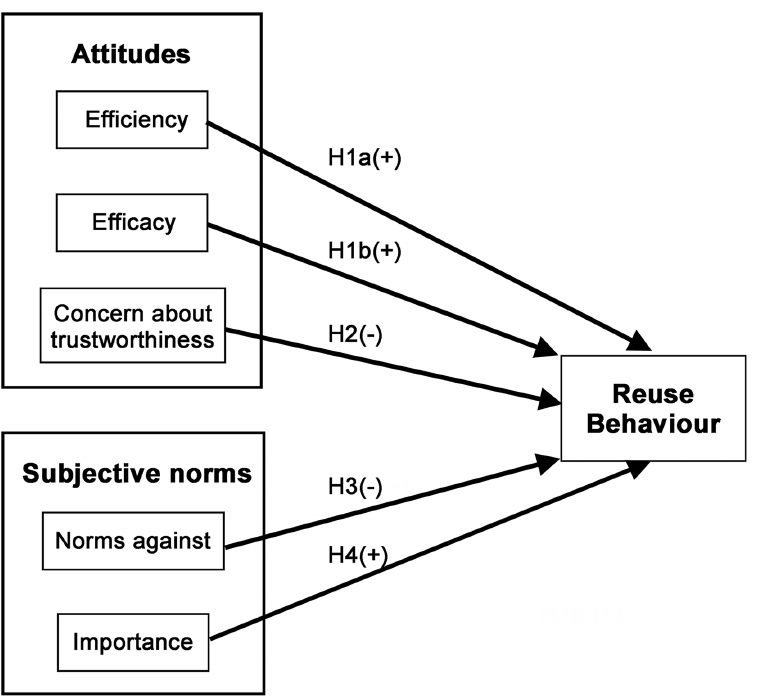
Fig 2. Researchmodel. H1a: Perceived efficiency of data reuse will positivelycorrelate with data reuse; H1b: Perceived efficacy of data reuse will positivelycorrelate with data reuse; H2: Concernsabout the trustworthiness of data will negativelycorrelate with data reuse; H3: Perceived norms againstdata reuse will negatively correlate with data reuse; and H4: Perceivedimportance of data reuse will positivelycorrelate with data